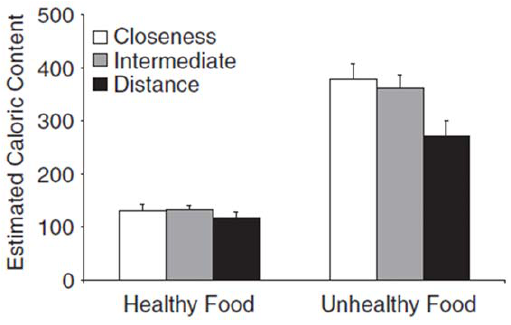
Figure 3. Results of Williams and Bargh (2008).